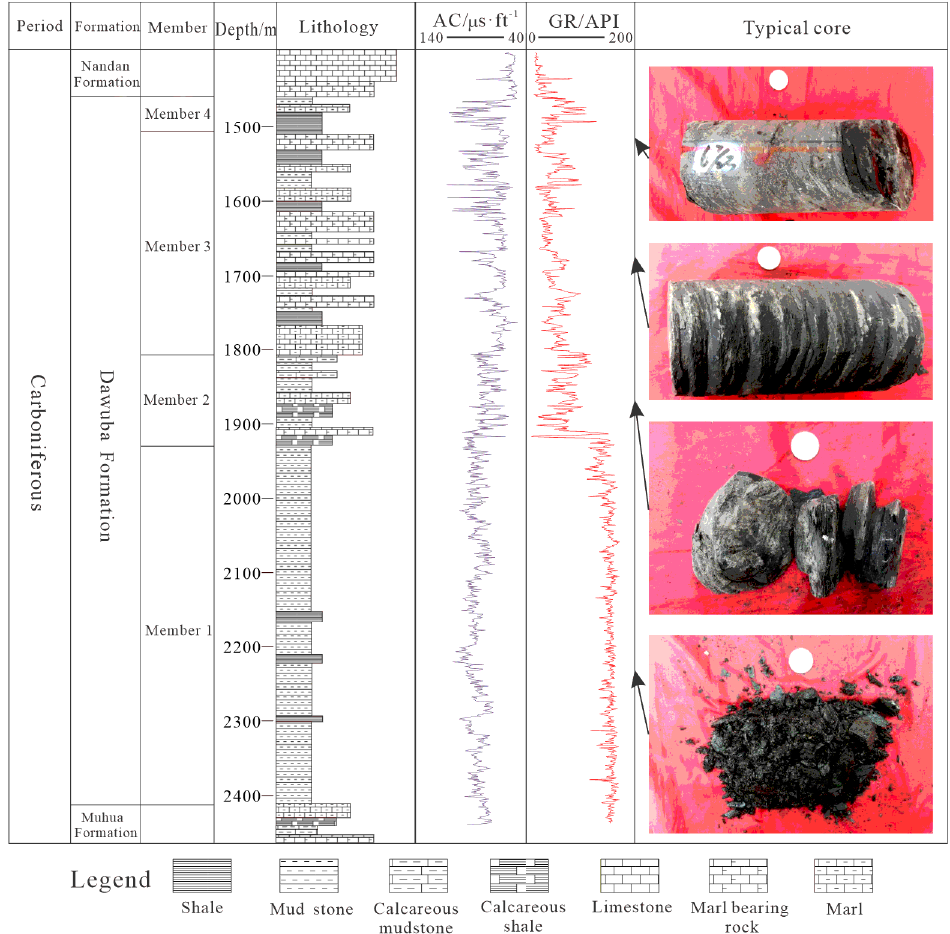
Figure 2. Stratigraphic characteristics and division scheme of the Dawuba Formation in Well QSD-1.